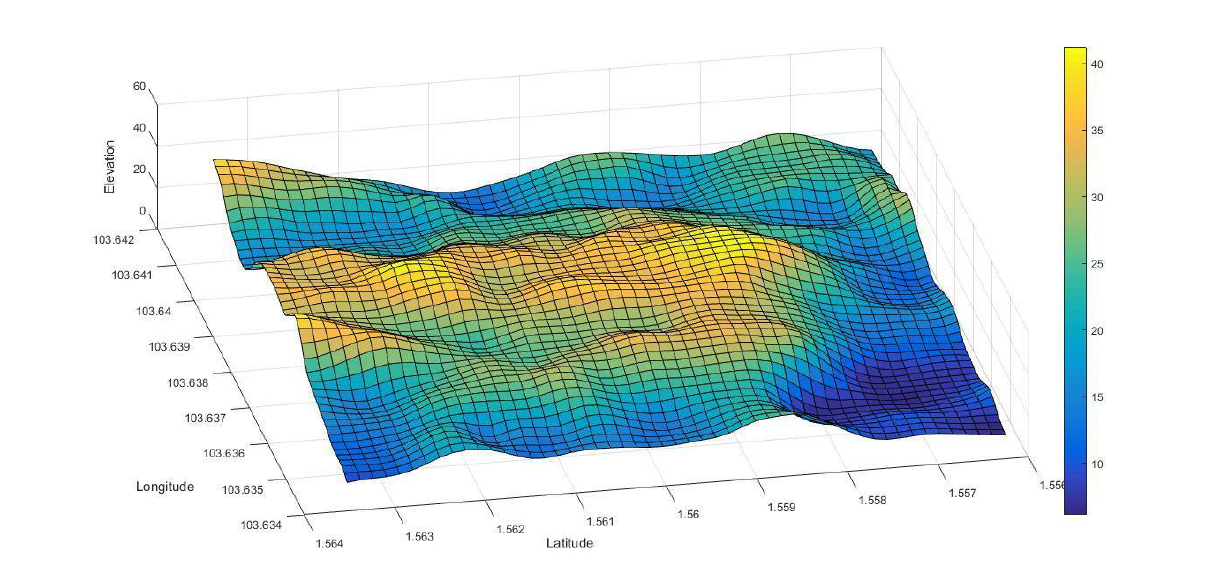
Figure 2. 3D terrain modelling from elevation data using piecewise cubic spline interpolation.